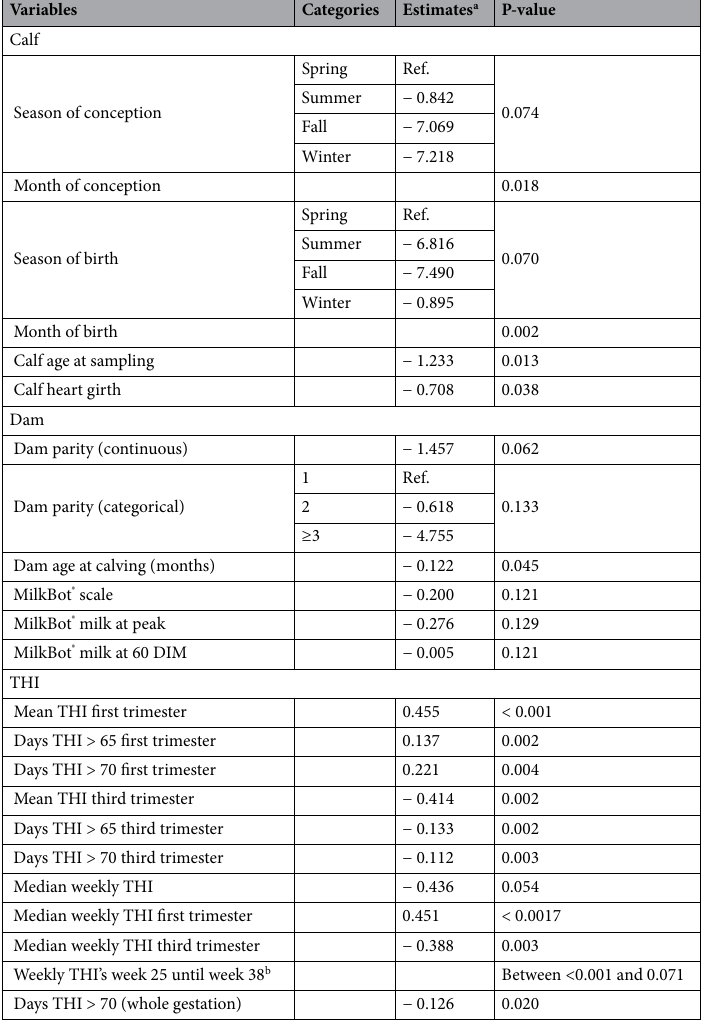
Table 2. Results of the univariable model showing variables associated with the log 10 transformed TL (P < 0.15). a Estimates presented as a % difference in TL for a 1-unit increase in the explanatory variable. b Detailed weekly THI’s between week 20 and 39, see Supplementary file